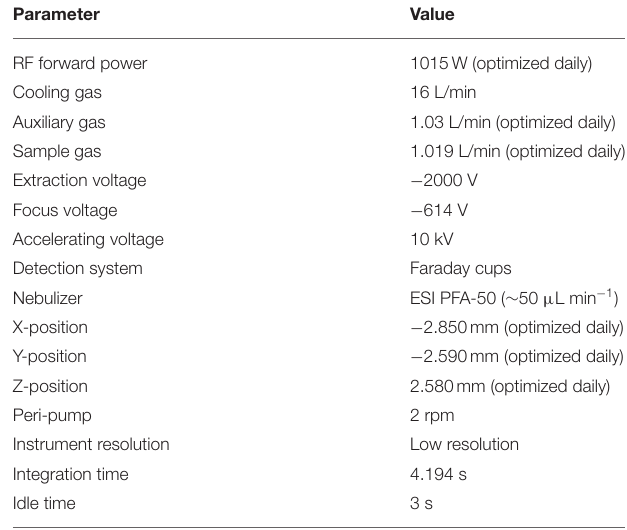
TABLE 3 | Typical MC-ICP-MS operating parameters for Li isotopic